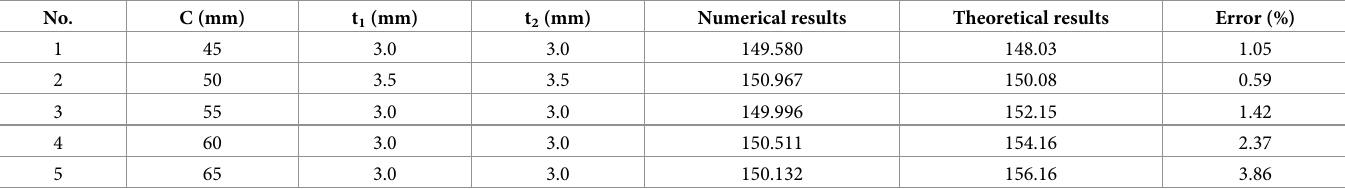
Table 3. Differences in the FE results and theoretical